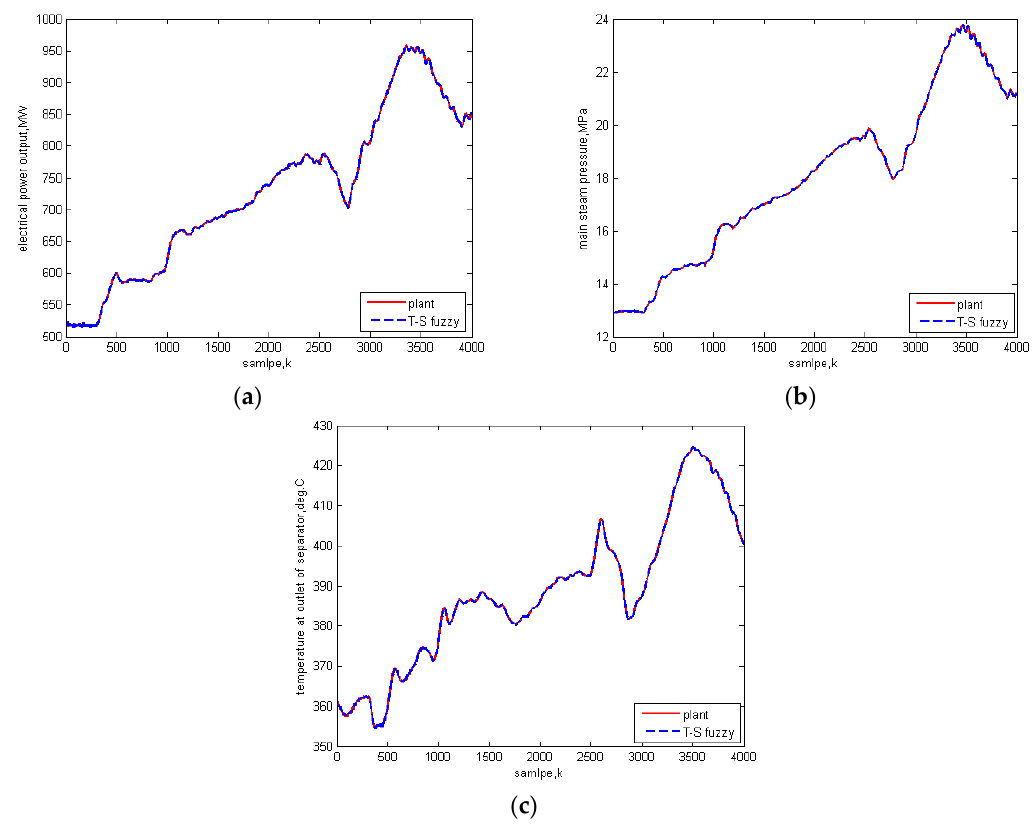
Figure 4. ( a ) Comparison of the T ‐ S fuzzy model and training data for electrical power output; ( b ) Comparison of the T ‐ S fuzzy model and training data for main ‐ steam pressure; ( c ) Comparison of the T ‐ S fuzzy model and training data for the separator outlet steam temperature.